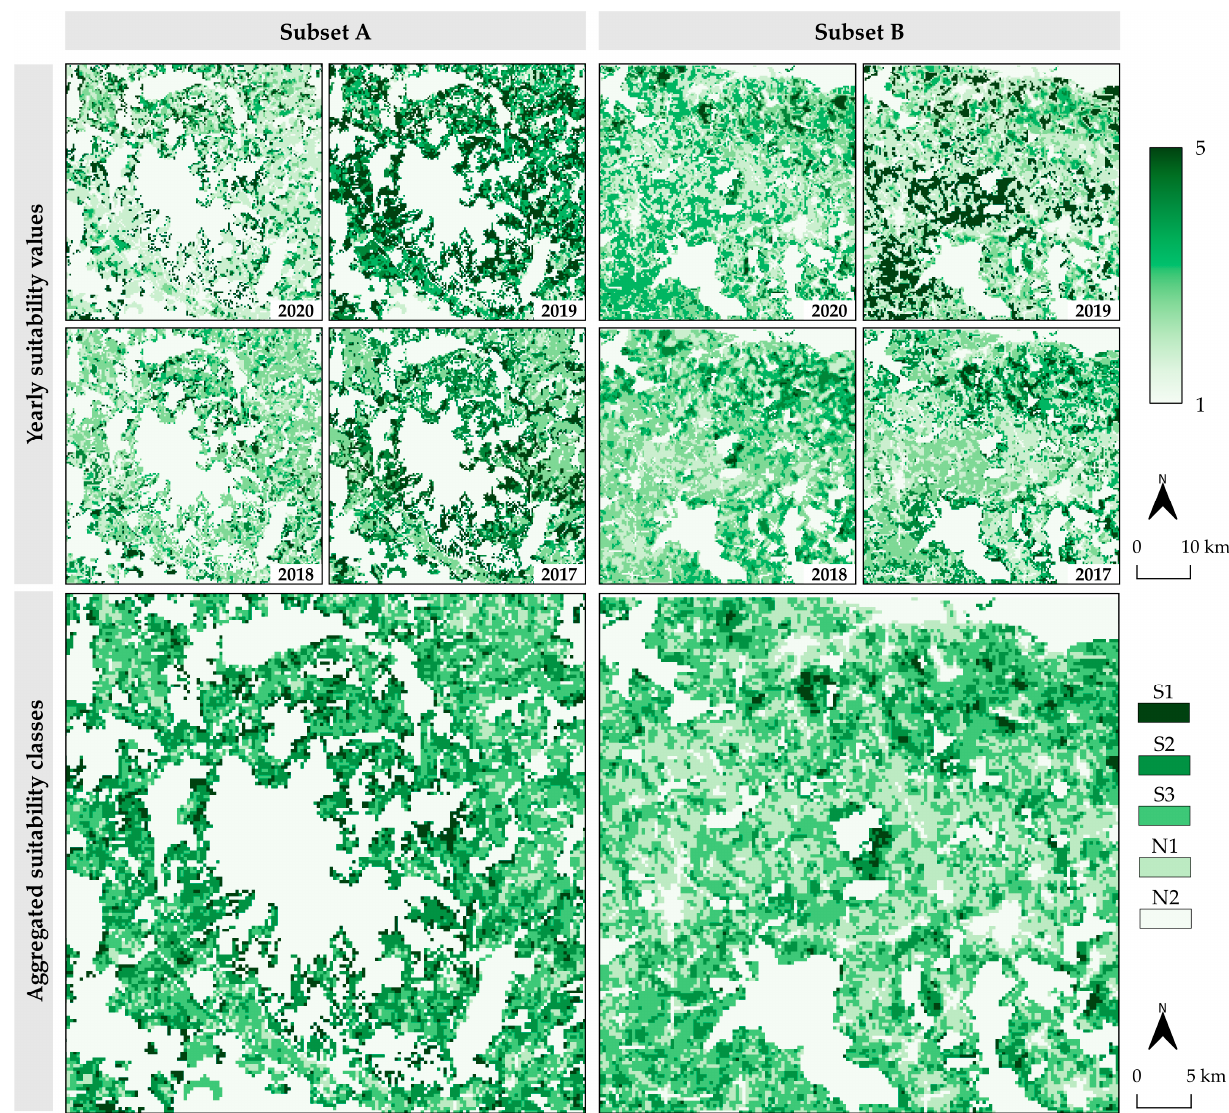
Figure 8. Yearly and aggregated cropland suitability classes for soybean cultivation.